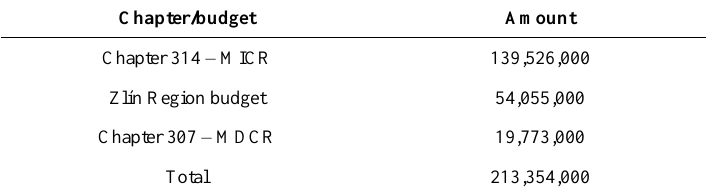
Table 1. Funds from Chapter 398 - VPA in connection with the Vrbětice emergency reassigned to chapters and budgets in